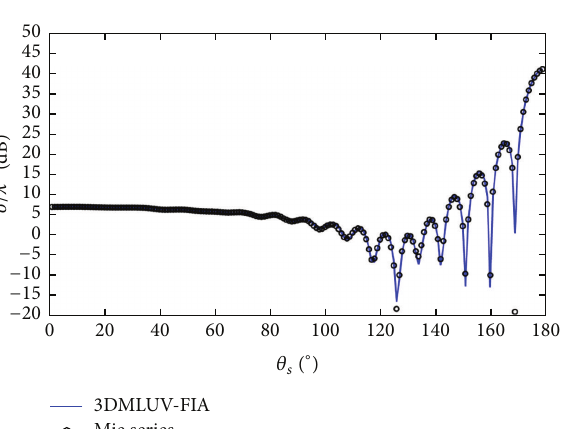
Figure 3: Permittivity 𝜀 𝑟 = 4 − 3𝑗, 𝑟 = 3𝜆 , RCS from dielectric